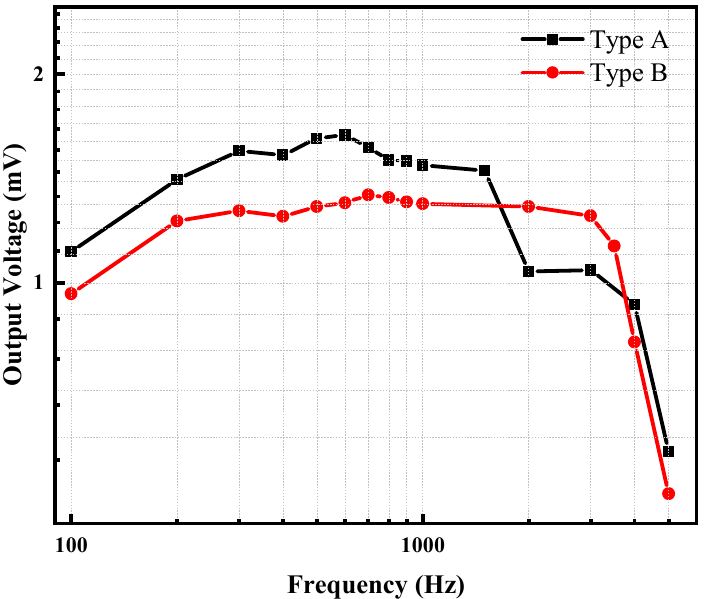
Figure 8. Frequency response curve formed by single frequency sweeps of the experiment system.